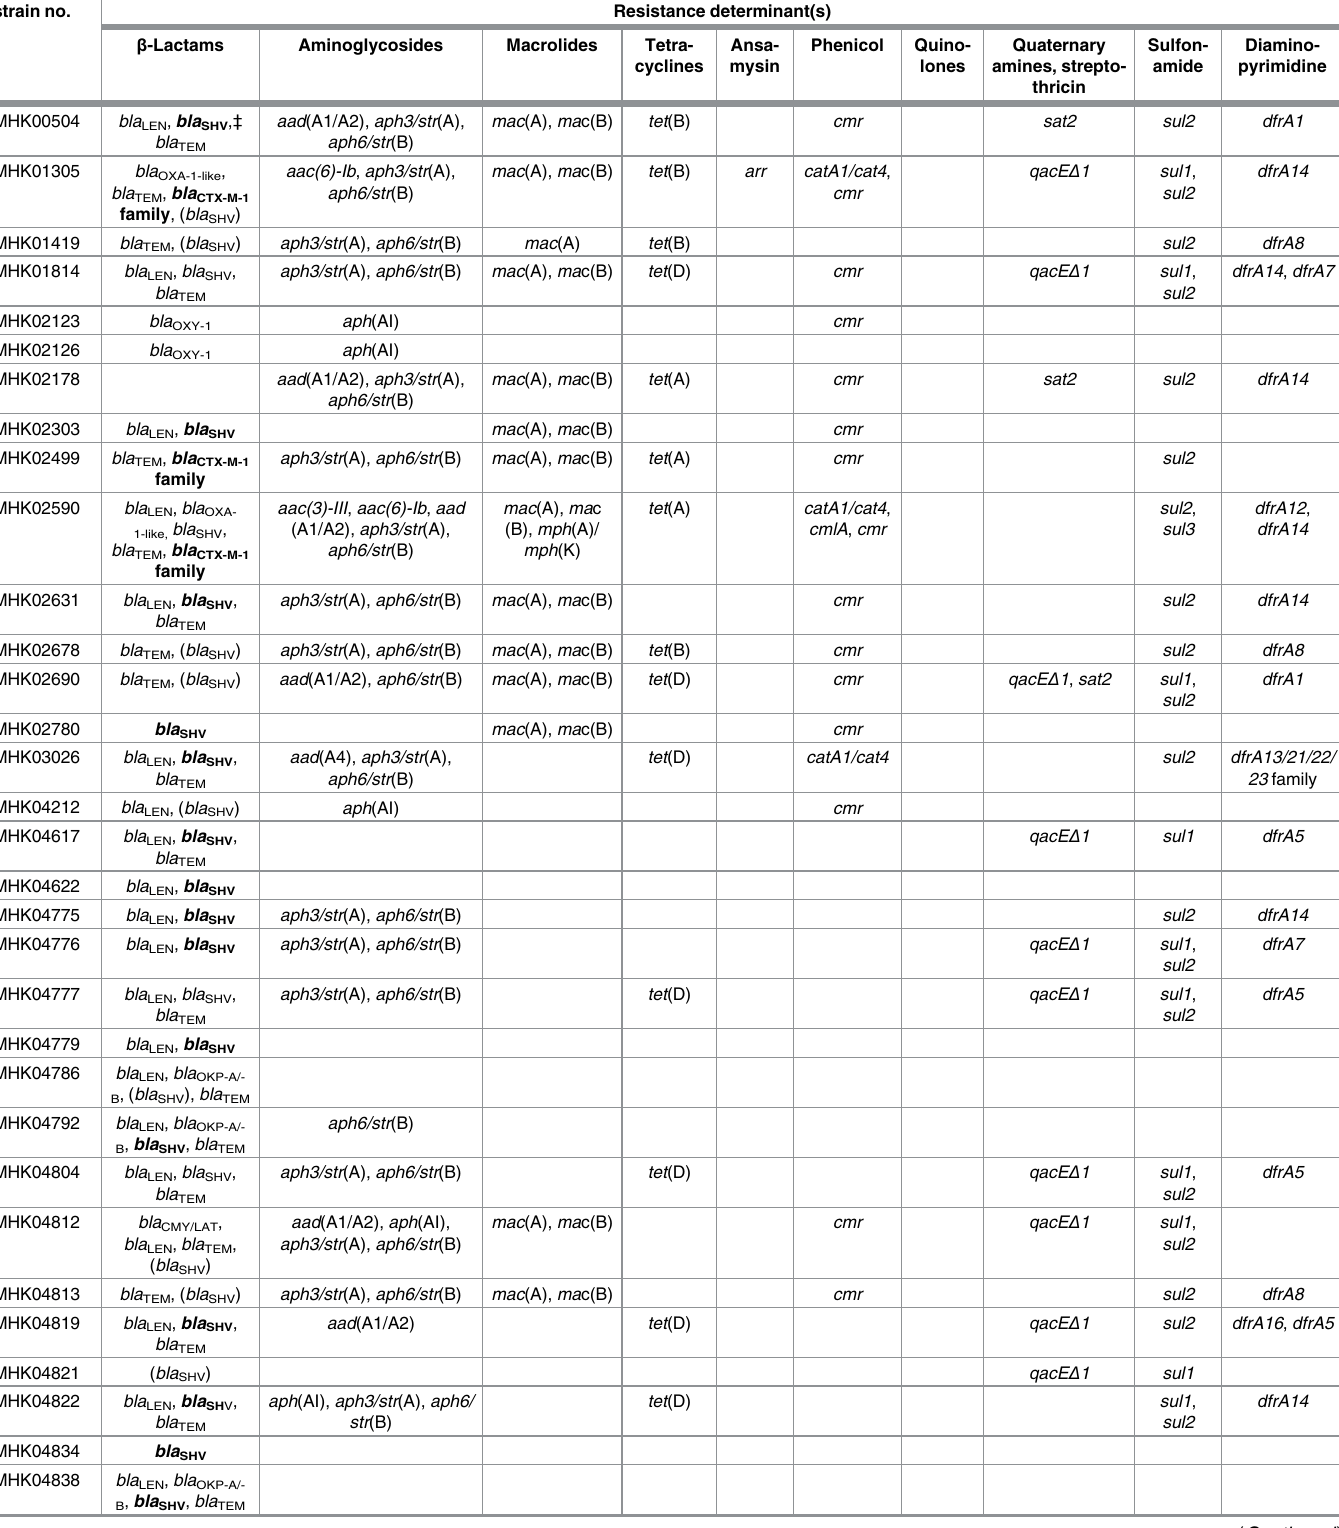
Table 4. AMR genes present in individual Kenyan Klebsiella spp. isolates. strain